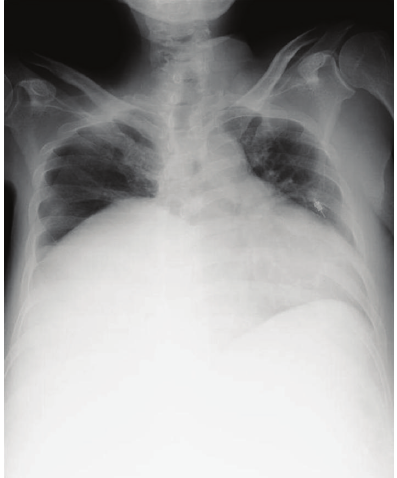
Figure 2: Chest X-ray showed that elevation of the diaphragm due to rapid growth of retroperitoneal tumor and cardiac enlargement.